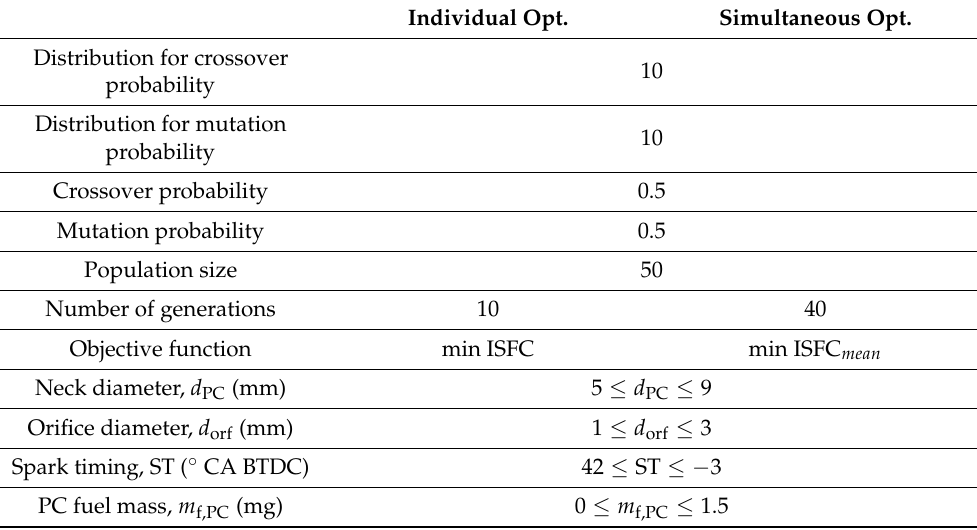
Table 5. Overview of optimization settings, objective functions, variables and constraints for individ- ual and simultaneous optimization. Individual Opt.